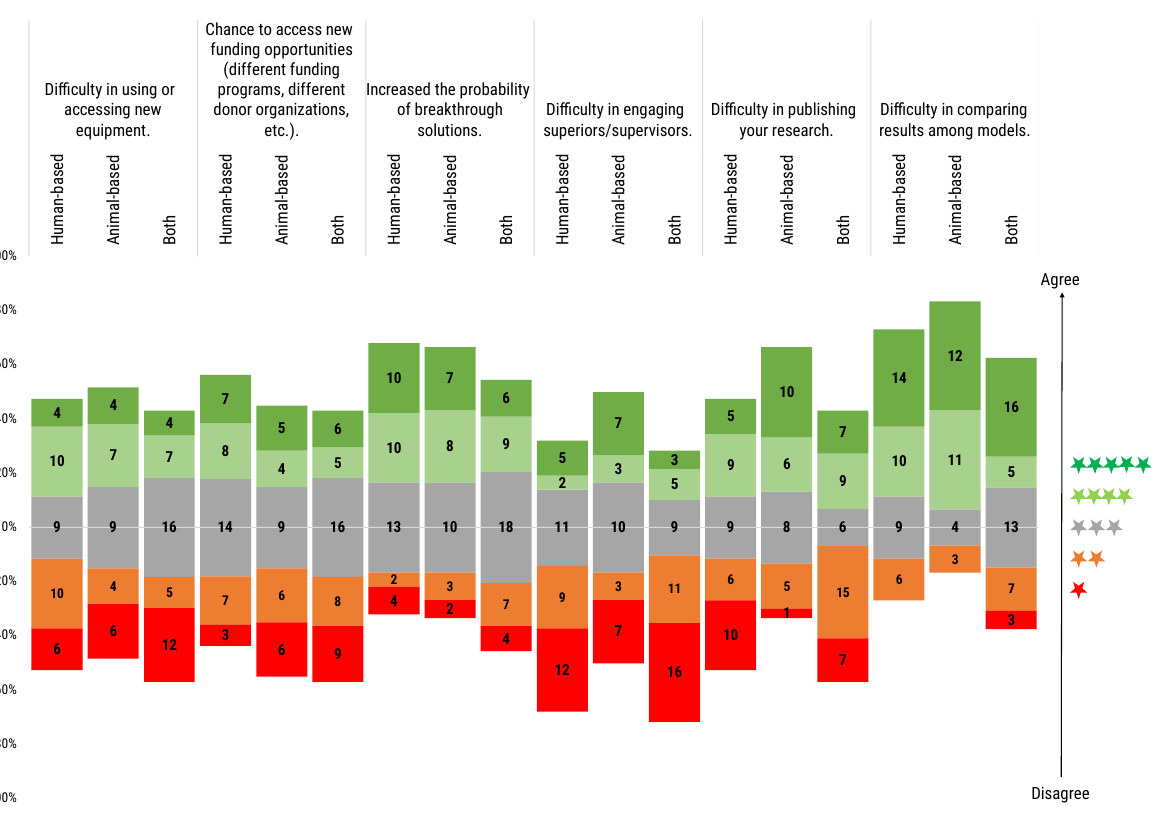
Figure 4. Participants were asked to rate the answers to the following question regarding concerns and benefits of use non-peer- reviewed models, “If you had the need to use a still -non-peer-reviewed model or method, how would you rate the following concerns and benefits?”. Rating scale was from 1 (red) to 5 (dark green) stars. Histogram dimensions are represented as 100%, where 100% is the total number of participants of each subgroup: human-based (39), animal-based (30) and both (44) model users. The stacked chart, calibrated around the neutral score (3 stars), shows the number of respondents based on their degree of agreement and segmented by researchers’ use of animal - or human-based or both models.